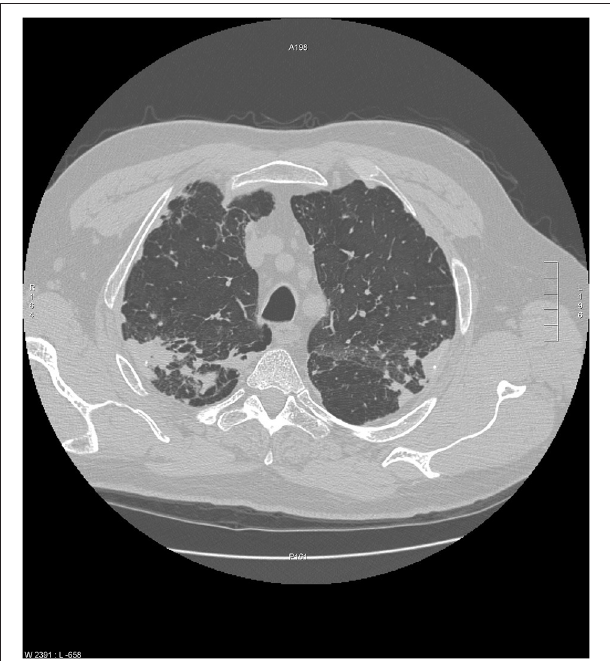
FIGURE 7 | Another chest CT scan image from the same scan as Figure 6 showing peripheral and subpleural opacities. Reproduced with permission from Judson